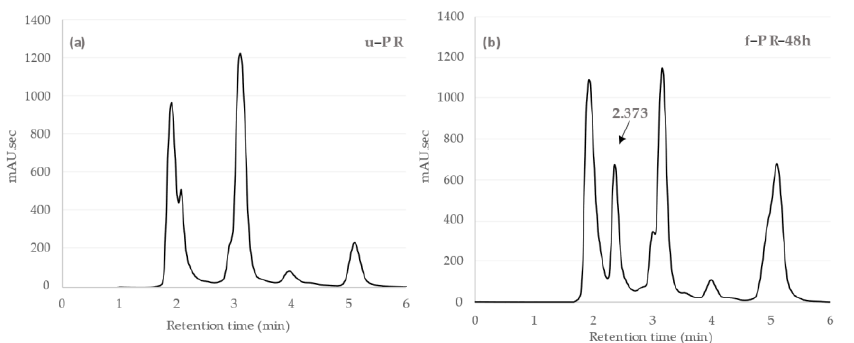
Figure 3. ( a ) HPLC chromatogram of PR extract without fermentation (u-PR) and ( b ) HPLC chro- matogram of PR extract after 48 h fermentation (f-PR-48h). A new peak appeared at the retention time (Rt) 2.373 min, indicated by an arrow.